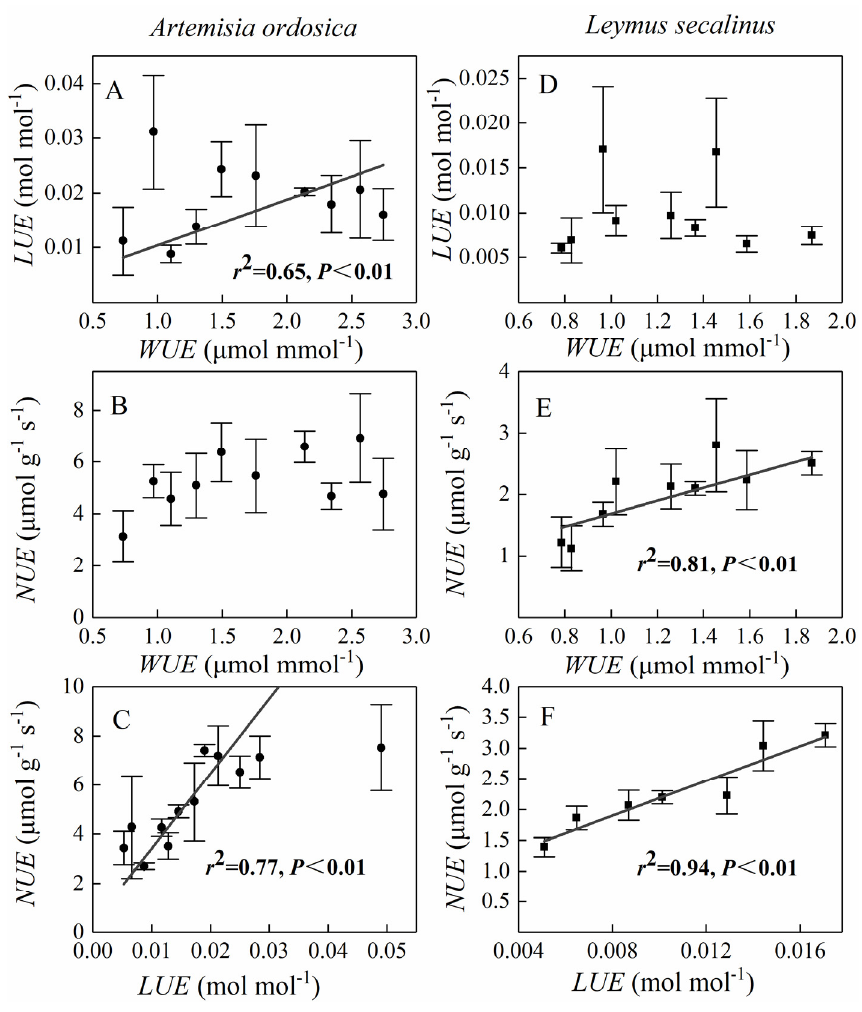
Figure 7. Relationships between resource use efficiencies (i.e., WUE , LUE , and NUE ) during the growing season. Relationships between LUE and WUE ( A ), WUE and NUE ( B ), LUE and NUE ( C ) for A. ordosica and relationships between LUE and WUE ( D ), WUE and NUE ( E ), LUE and NUE ( F ) for L. secalinus . Data points are binned averages, with WUE and LUE specified in increments of 0.2 μ mol mmol − 1 and 0.002 mol mol − 1 , respectively. Bars indicate standard error of estimate.